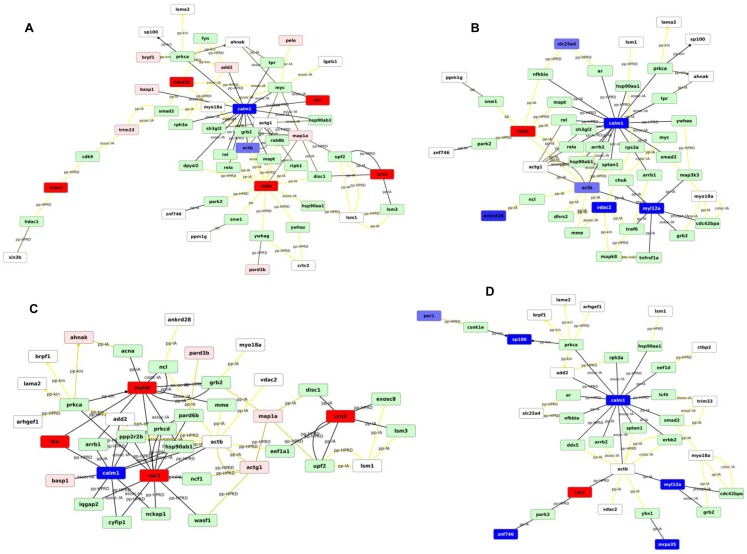
Networks of proteins based on enriched gene ontology functions.Response networks were constructed with Network Express [46] by using the corresponding iTRAQ proteins as seed nodes from the four scenarios described in the legend for Tables 1 and 2 together with the quantitative values from the iTRAQ experiments. Networks were drawn with Cytoscape [51].A: VTRM1 IN + no change; B: VTRM1 OUT + no change; C: 16M IN + no change, D: 16M OUT + no change. IN  =  +, ++, +++ or ++++. OUT  =  -, —, --- or ----. Nodes: red: up-regulated (IN) blue: down-regulated (OUT) white: no change (0) green: no data. The more red/blue, the higher the fold-change. Full red/blue for the highest bracket of the iTRAQ scores. Edges: black: high score (“strong/likely connection”) yellow: low score (“weak/less likely connection”).